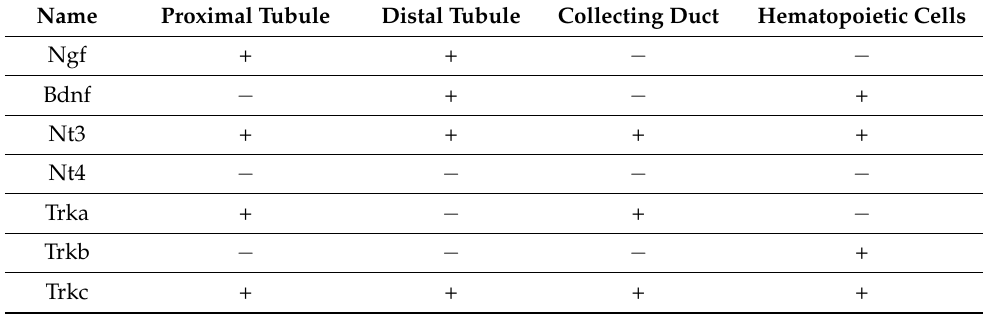
Table 2. Summary of all results obtained by in situ hybridization and